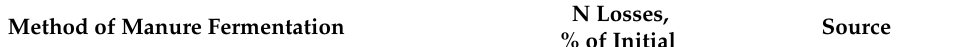
Table 3. The losses of nitrogen from manure depending on the method of fresh manure fermentation. Method of Manure